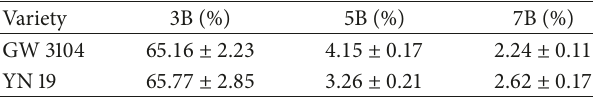
Table 2: Physical and chemical properties of different wheat